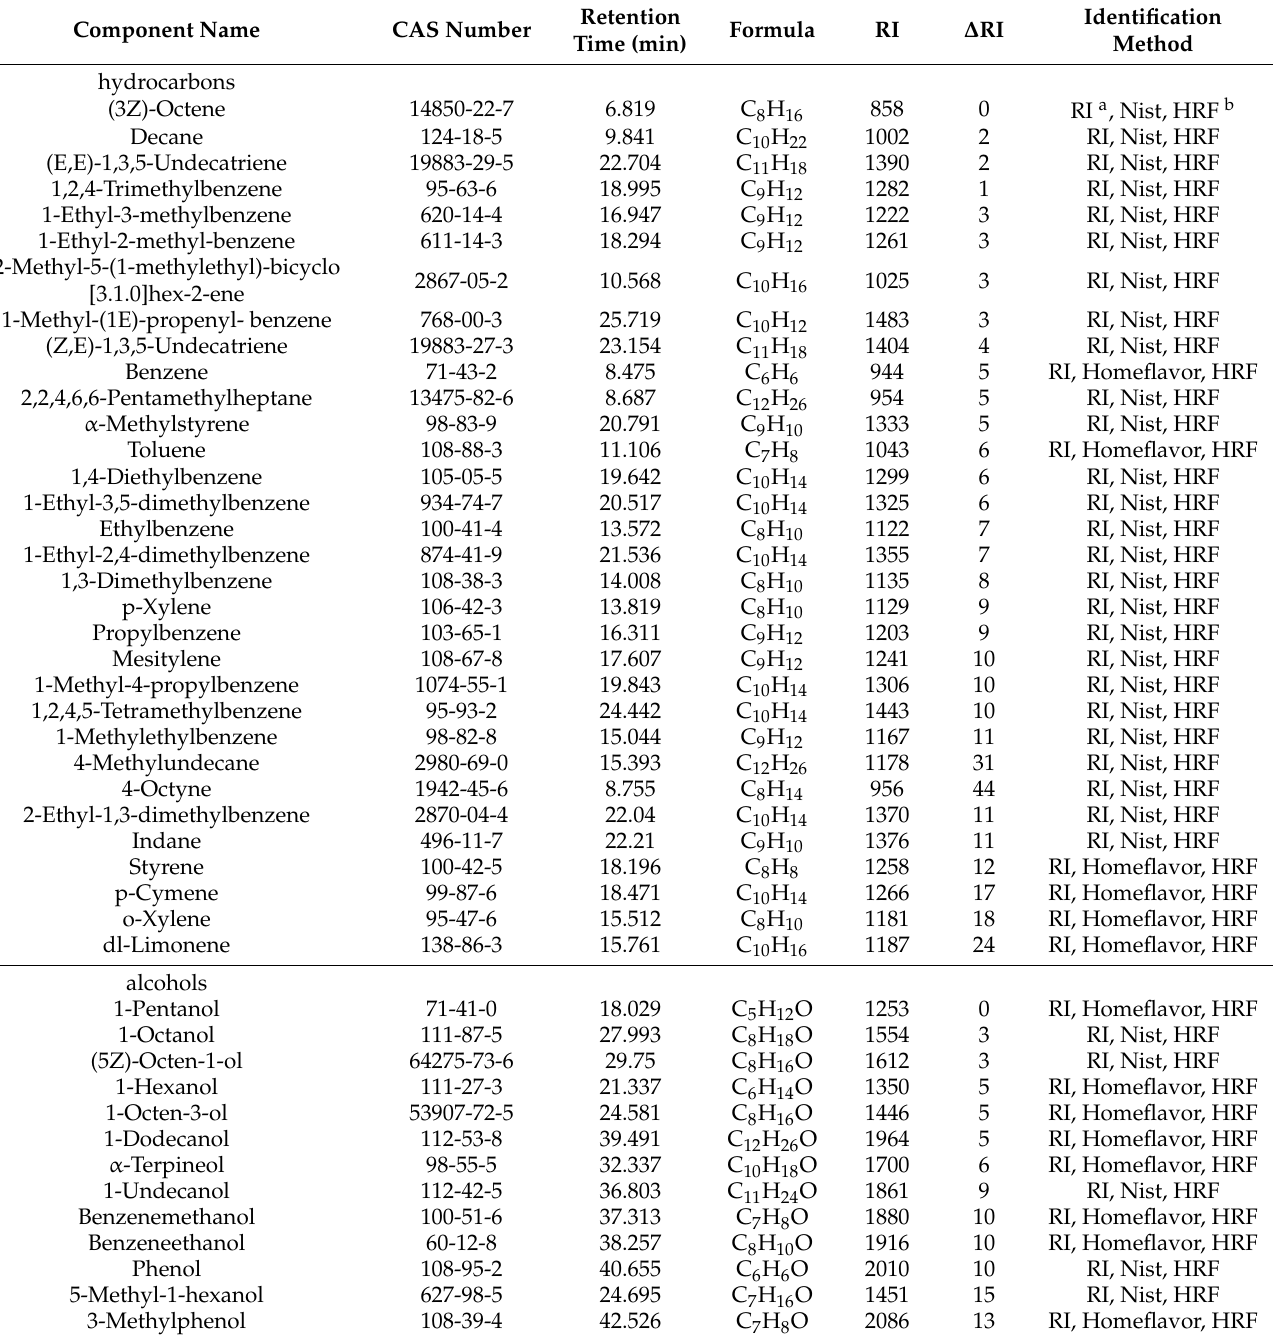
Table 1. Volatile compounds identified in five different